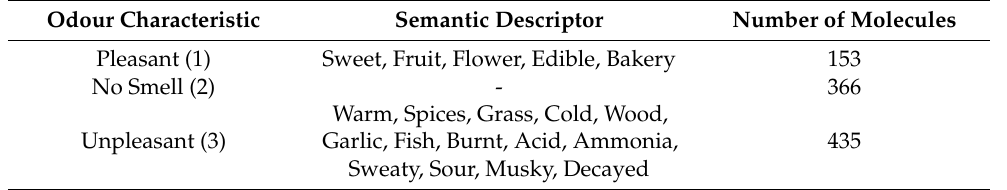
Table 3. Classification of molecules.